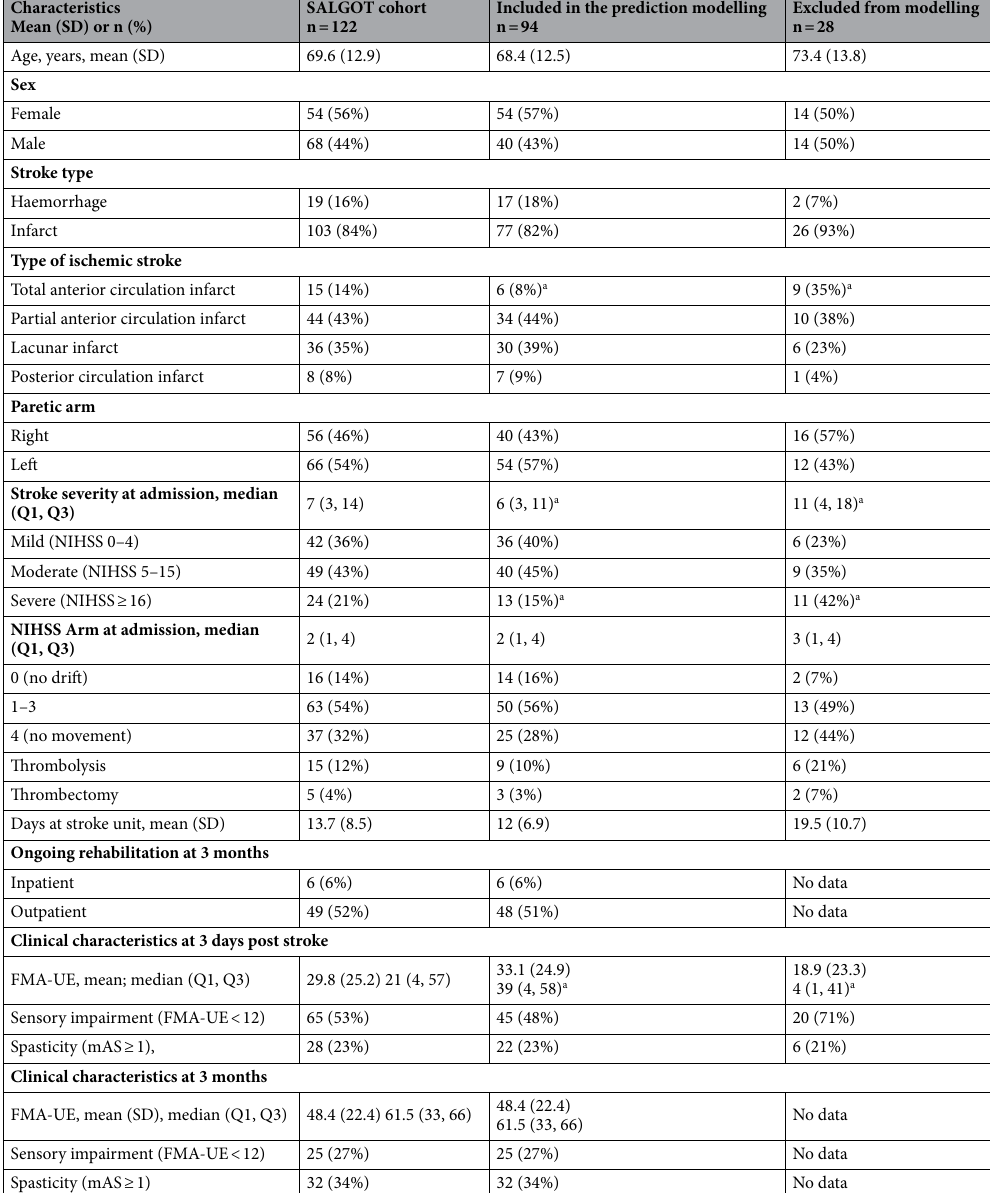
Table 1. Baseline demographic and clinical data for all patients, patients who survived and patients who informed the modelling process. a Statistically significant difference between included and excluded patients